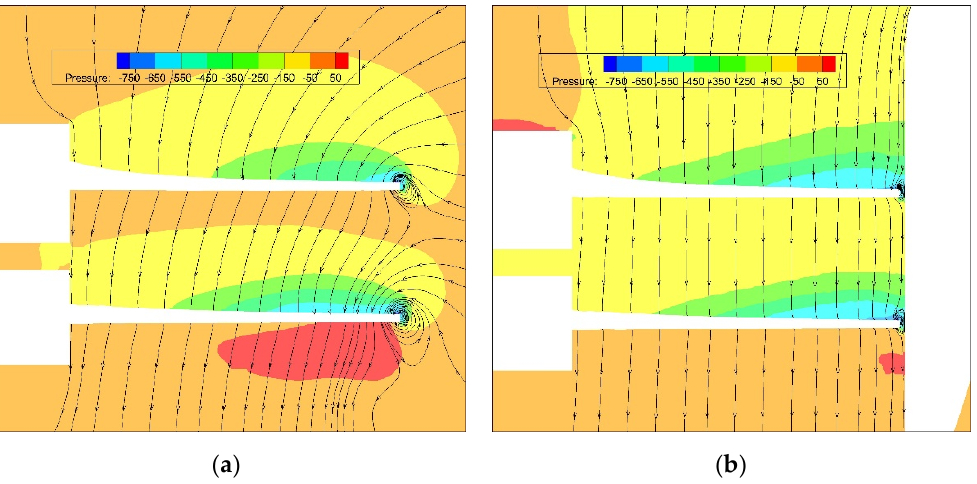
Figure 13. Pressure contour and streamline of coaxial propellers and ducted fan UAV: ( a ) Unducted propellers; ( b ) Ducted fan UAV.